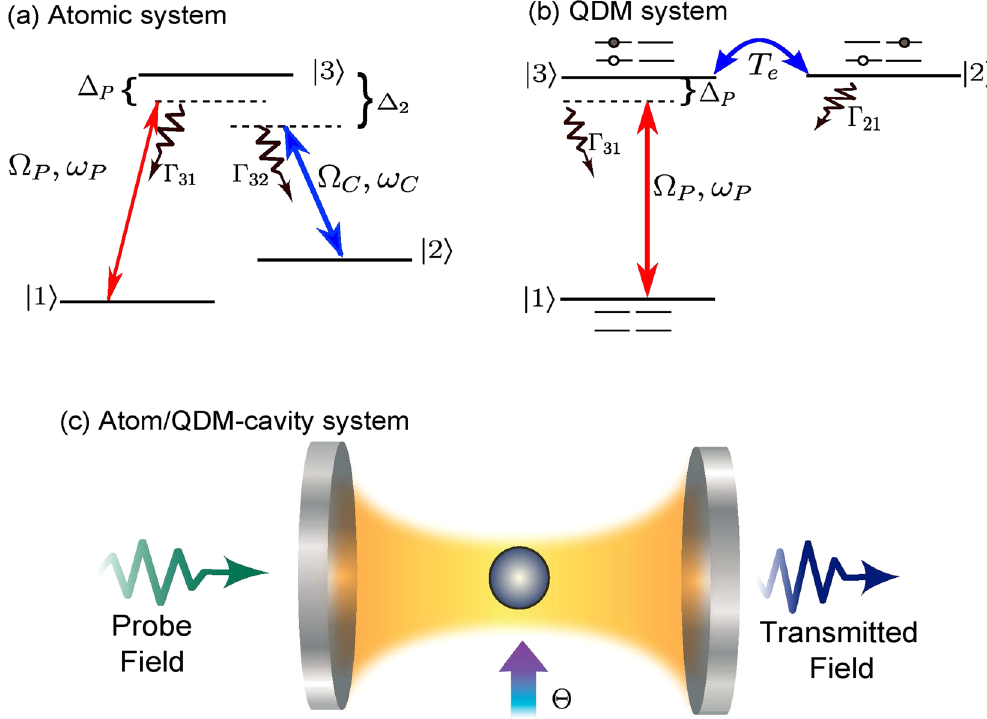
Figure 1. Schematic representation of the system. Diagram of levels: ( a ) for the atomic and ( b ) QDM systems. In ( c ) we show an atom/QDM-cavity system which can be used to verify the nonlinear effects predicted